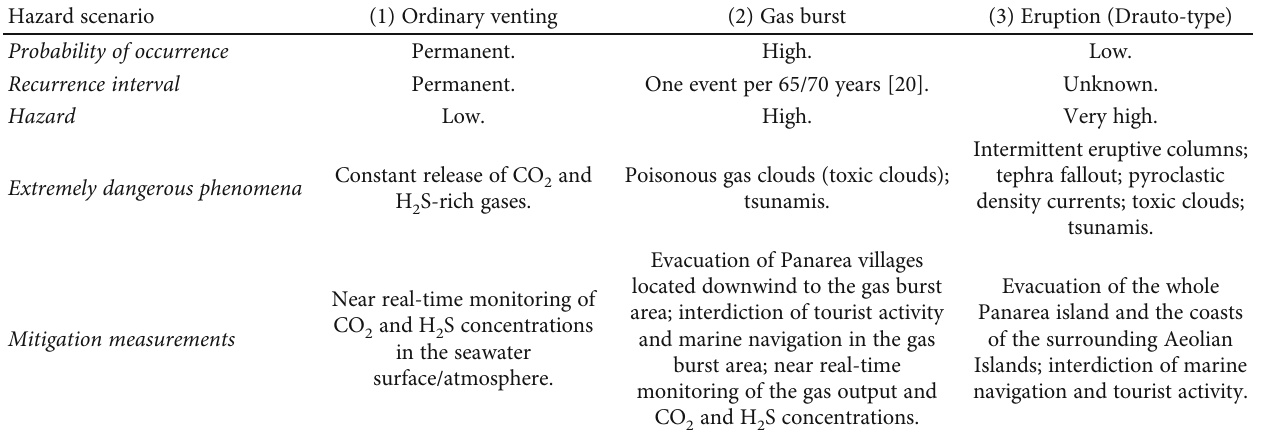
Table 2: Hazard scenarios connected to Panarea